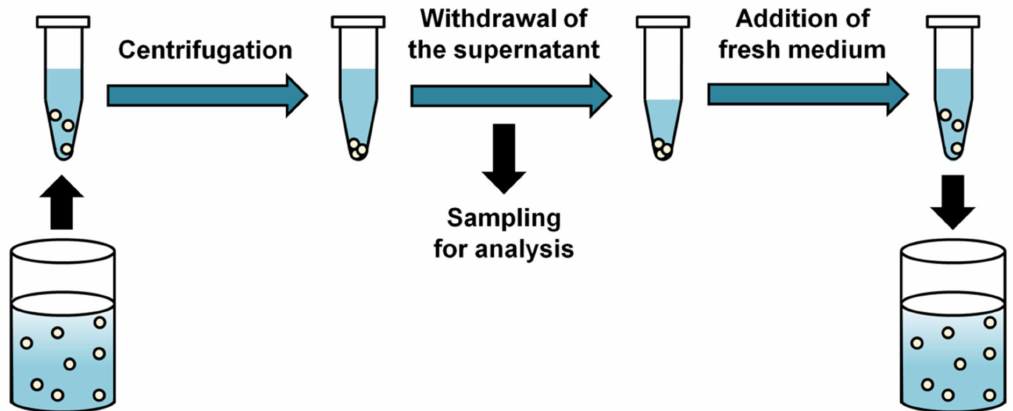
Figure 1. Basic principle and process of sample and separate method for in vitro drug release testing